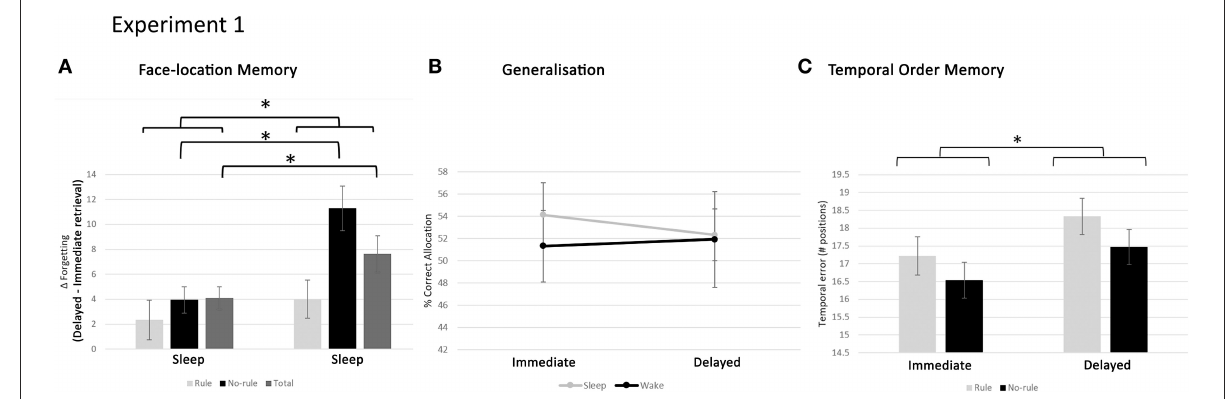
FIGURE5 Results of experiment 1. (A) Forgetting rate for face locations, in the sleep and wake group, for the rule, no-rule, and total faces. Overall, retention is higher in the sleep group compared to the wake group and higher for rule items than no-rule items. Furthermore, no-rule items specifically are retained better in the sleep group than the wake group, suggesting sleep protects against episodic memory decay. (B) Correct allocation of new faces to screen locations, based on regularity knowledge, is indicated in percentage for the sleep and wake groups, directly after encoding (Immediate) and after 12h (Delayed). Over the 12-h interval, performance remained stable for both the sleep and wake group, indicating no preferential benefit from sleep. (C) Performance on the temporal order task, expressed as temporal order error (number of positions away from the correct one, averaged over all faces), parsed for sleep–wake and rule/no-rule conditions. Chance level performance is 24. There is overall forgetting over the retention interval, with no notable difference between the sleep and wake condition. Temporal order memory is slightly better for no-rule faces than rule faces across the sleep and wake groups and retrieval sessions. Thus, the presence of regularities might negatively impact memory for episodic details. * p < 0.05. Error bars represent the standard error of the mean.